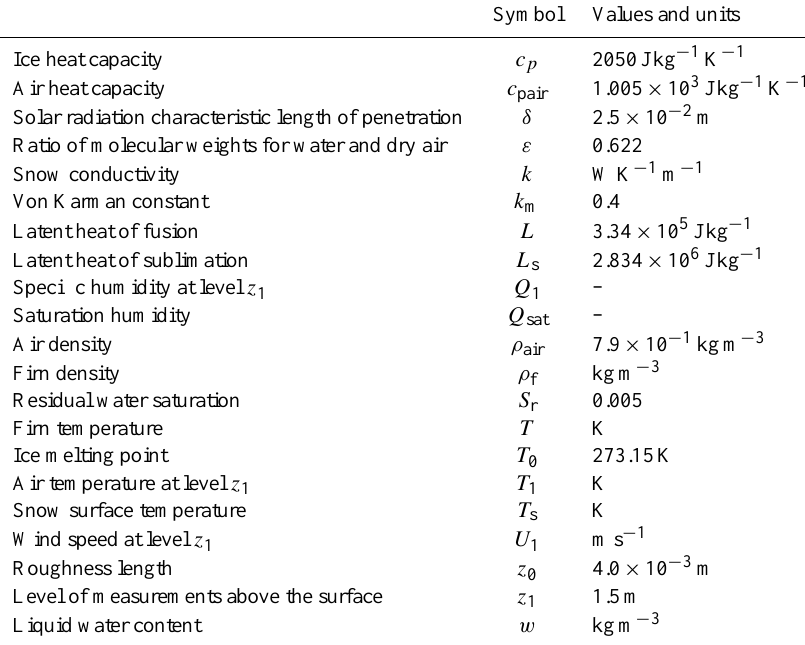
Table 2. Parameters and variables used in the SEB (model 1), with their respective values when